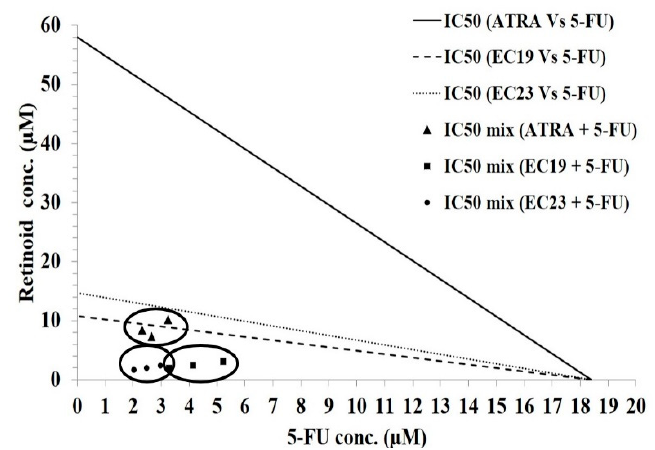
Figure 2. Isobologram analysis applied to Caco-2 cells co-treated with 5-FU in addition to ATRA, EC19, or EC23 for 24 h. The antagonistic (upper), the synergistic (lower), and the additivity (on the line) regions are shown. The analysis indicates synergism at the IC 50 level. Data points in circles represent the mean of 3 independent replicates.